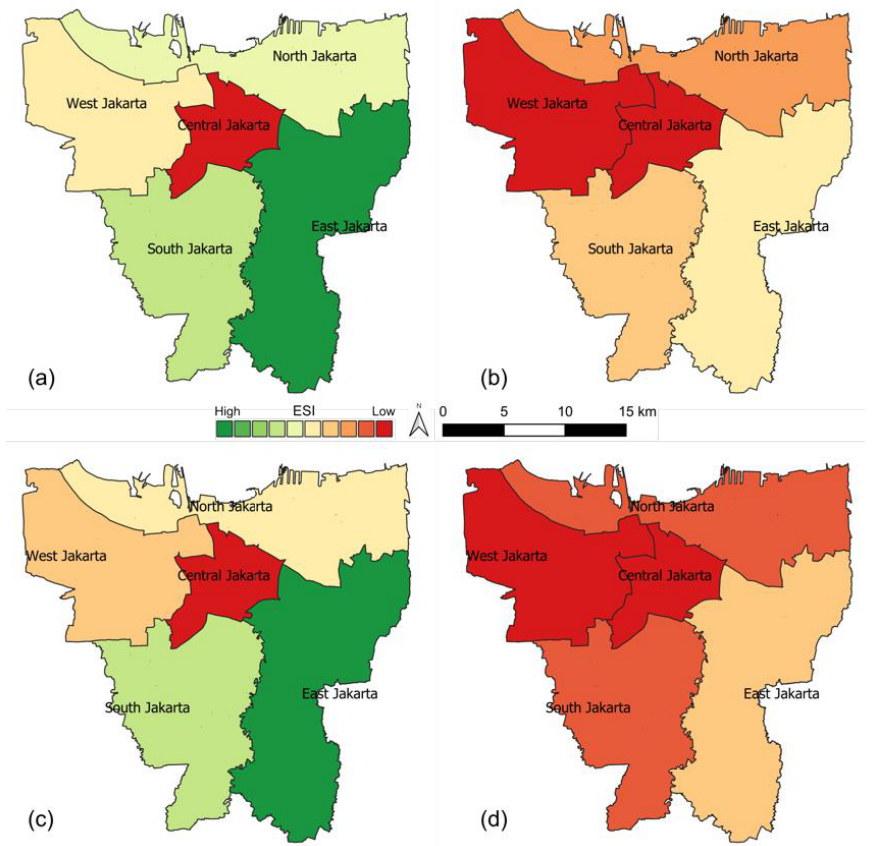
Figure 11. Ecosystem services index (ESI) for temperature regulation in the year 1995 and 2014. ( a ) ESI in 1995 without landscape metric area (LMA); ( b ) ESI in 2014 without LMA; ( c ) ESI in 1995 with LMA; and ( d ) ESI in 2014 with LMA.